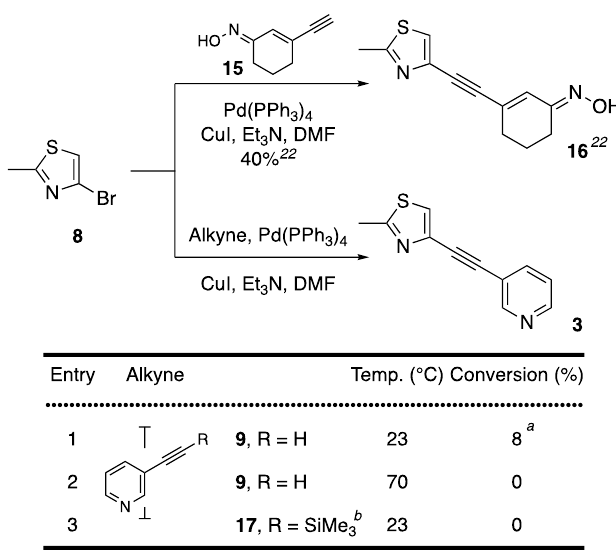
Figure 2 4-Bromo-2-methylthiazole ( 8 ) as a reacting partner in Sonogashira coupling en route